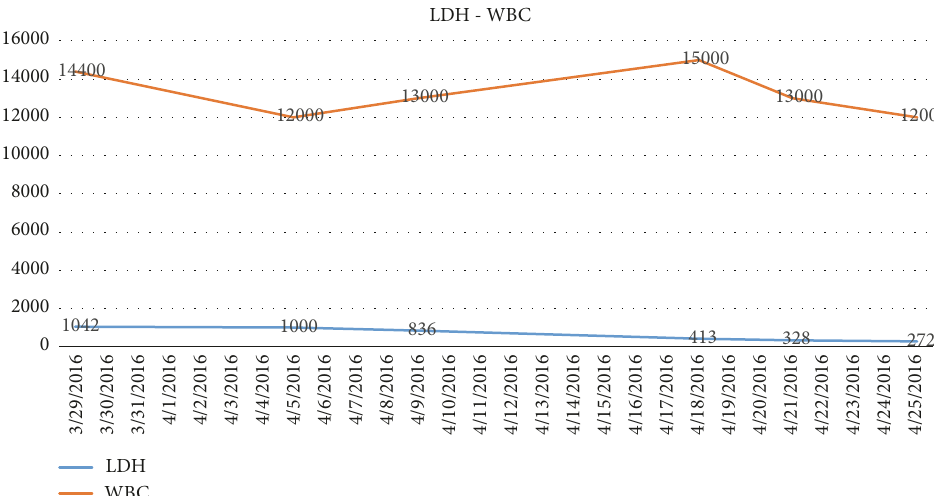
Figure 4: We keep track of white blood cells and LDH showing the impact on all blood lines and hemolytic